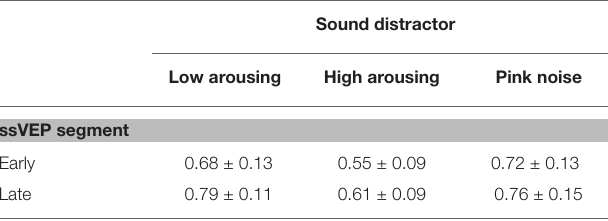
Means ± standard error of the means are shown.